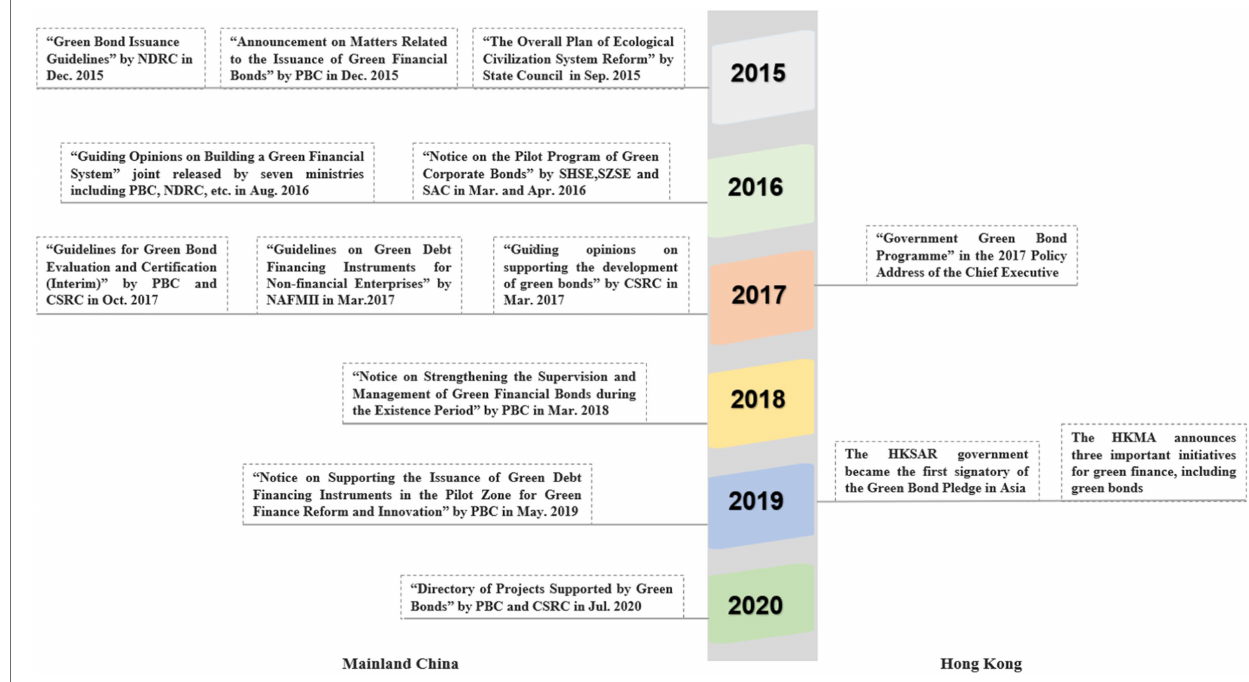
FIGURE 1 | The overview of green bond regulations in Mainland China and Hong Kong from 2015 to